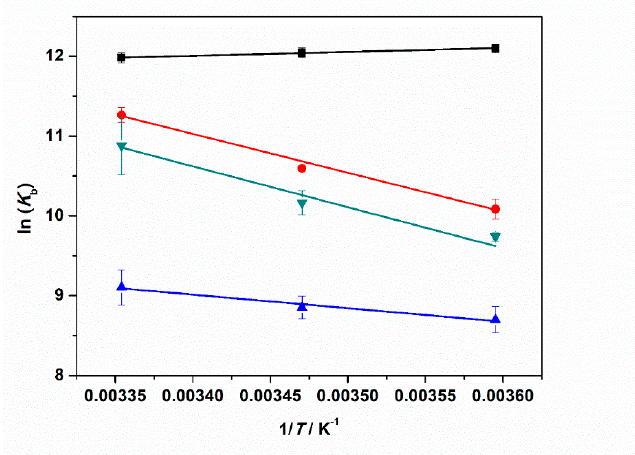
Figure 7. Plots of ln( K b ) vs. 1/ T for the complex formation between tRNA and ThT in the absence (black squares) and in the presence of: 1 mM MgCl 2 (red circles), 1 mM MgSO 4 (blue triangles), and 1 mM Mg(ClO 4 ) 2 (reversed dark cyan triangles). All the experiments were performed in 20 mM tris-HCl buffer, 40 mM KCl, pH 6.9. The solid lines represent the best fits to the experimental data. The slope of ln( K b ) vs. 1/ T is equal to - ∆ H ◦ b / R (Equation (2)), allowing estimation of the enthalpy change of binding, ∆ H ◦ b